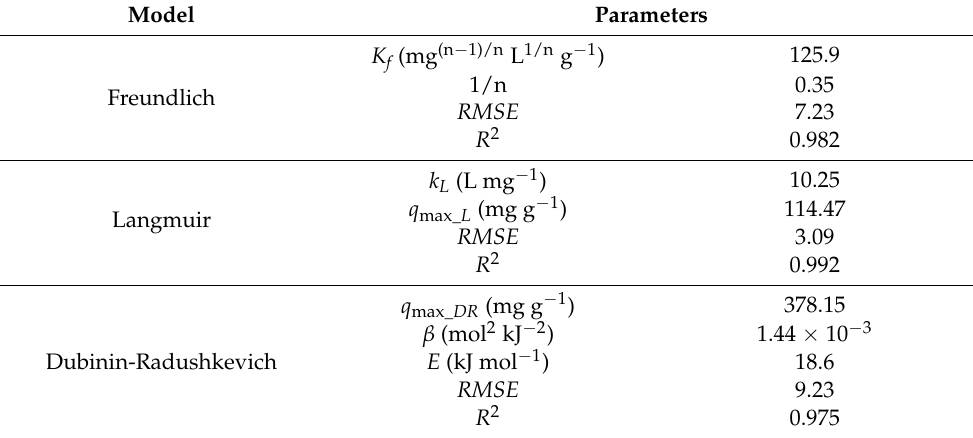
Table 2. Adsorption capacity of Pb (II) by different